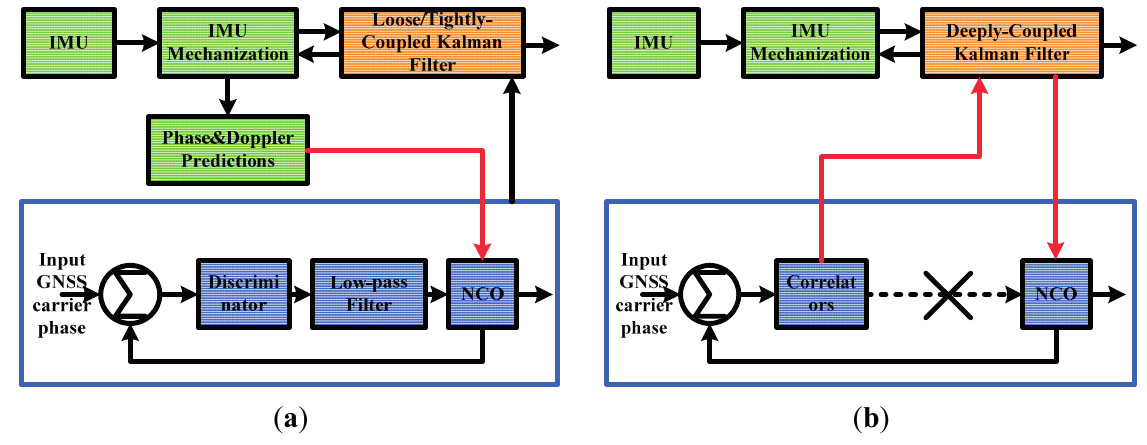
Figure 1. Two different architectures of GNSS/INS deeply-coupled integration. ( a ) Scalar-based architecture; ( b ) vector-based architecture. NCO means numerically controlled